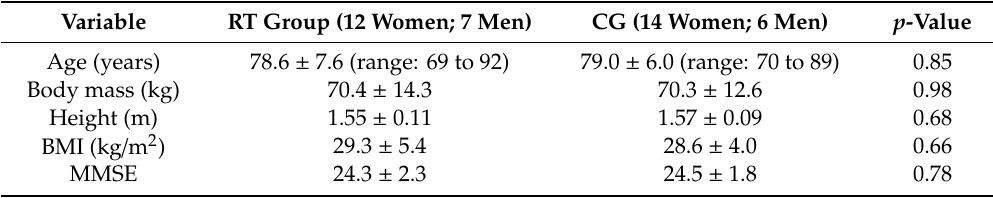
Figure 2. Study flow diagram; Abbreviations: CG: control group; RT: resistance training. Table 1. Participants’ characteristics at baseline.